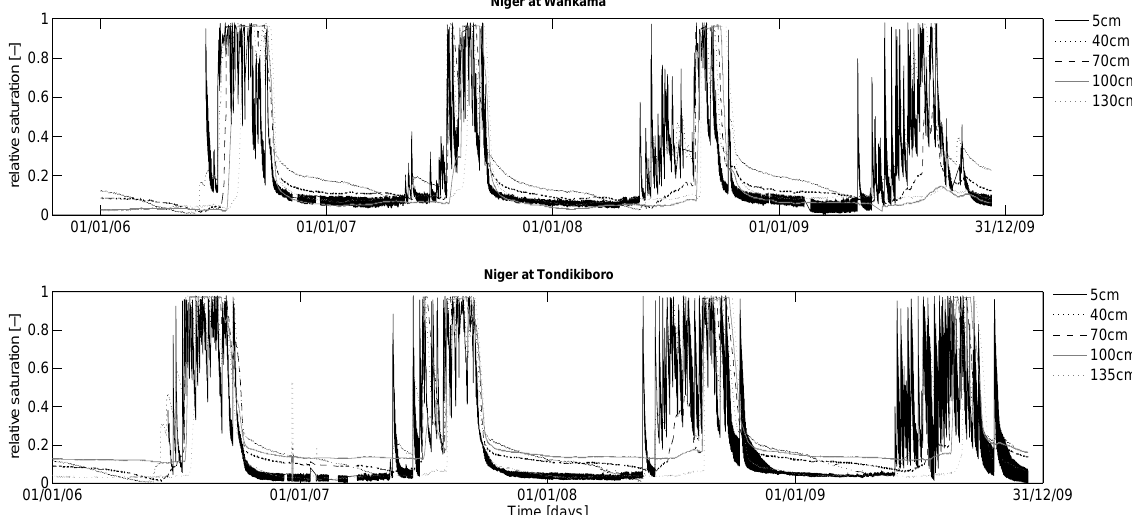
Fig. 3. Time series of the point measurements of the relative saturation of soil at the two stations of the AMMA network Wankama and Tondikiboro in Niger. Point measurements provide a good description of the soil moisture variations along the soil profile with five or six measurements at different depths ranging from 5cm down to 100–135cm. Data refer to the period 13 May 2006–31 December 2009.